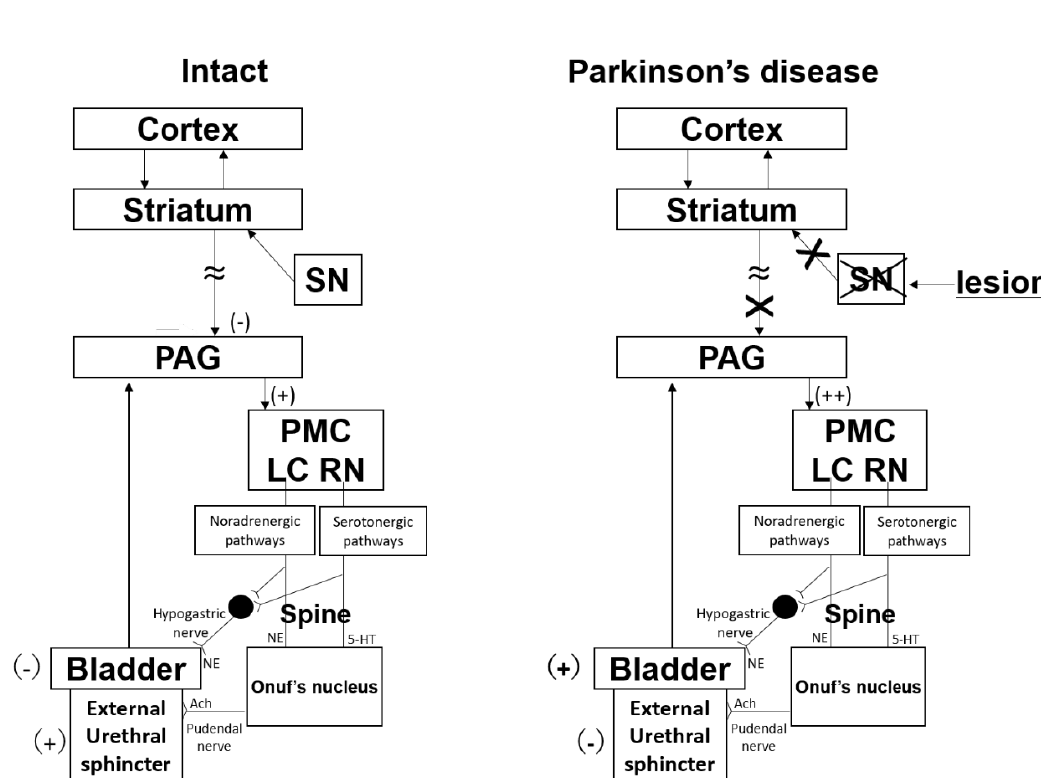
Figure 4. Working model for urethral dysfunction in PD. Schematic of our working model for urethral dysfunction. The active urethral closure mechanisms are regulated by the spinobulbospinal pathway. Intact: Descending signals of serotonergic and noradrenergic pathways from neurons in the raphe nucleus (RN) and locus coeruleus (LC), respectively. This neural circuit is under the control of the supraspinal regions and maintains urethral closure mechanisms. The descending signals travel downward to Onuf’s nucleus to innervate the external urethral sphincter and the pelvic floor muscle. Therefore, this neural system maintains active urethral closure mechanisms in the presence of increased inter-abdominal pressure. Under intact conditions, tonic inhibition (–) from supra-mesaticephalic sites suppresses bladder overactivity ( + ) and enhances urethral pressure (–). Parkinson‘s disease: PD dopaminergic neurons in the substantia nigra pars compacta (SN) are lost, and excitation ( + ) from the striatum is, therefore, decreased, leading to loss of the inhibitory functions of supra-mesaticephalic sites, including those of the cortex and supplementary motor areas (SMA). The loss of control results in facilitation of bladder overactivity ( + ) and inhibition of active urethral responses against increased intraabdominal pressure (–). 5-HT, 5-hydroxytryptamine; NE, norepinephrine; PAG, periaqueductal grey; PMC, pontine micturition center.